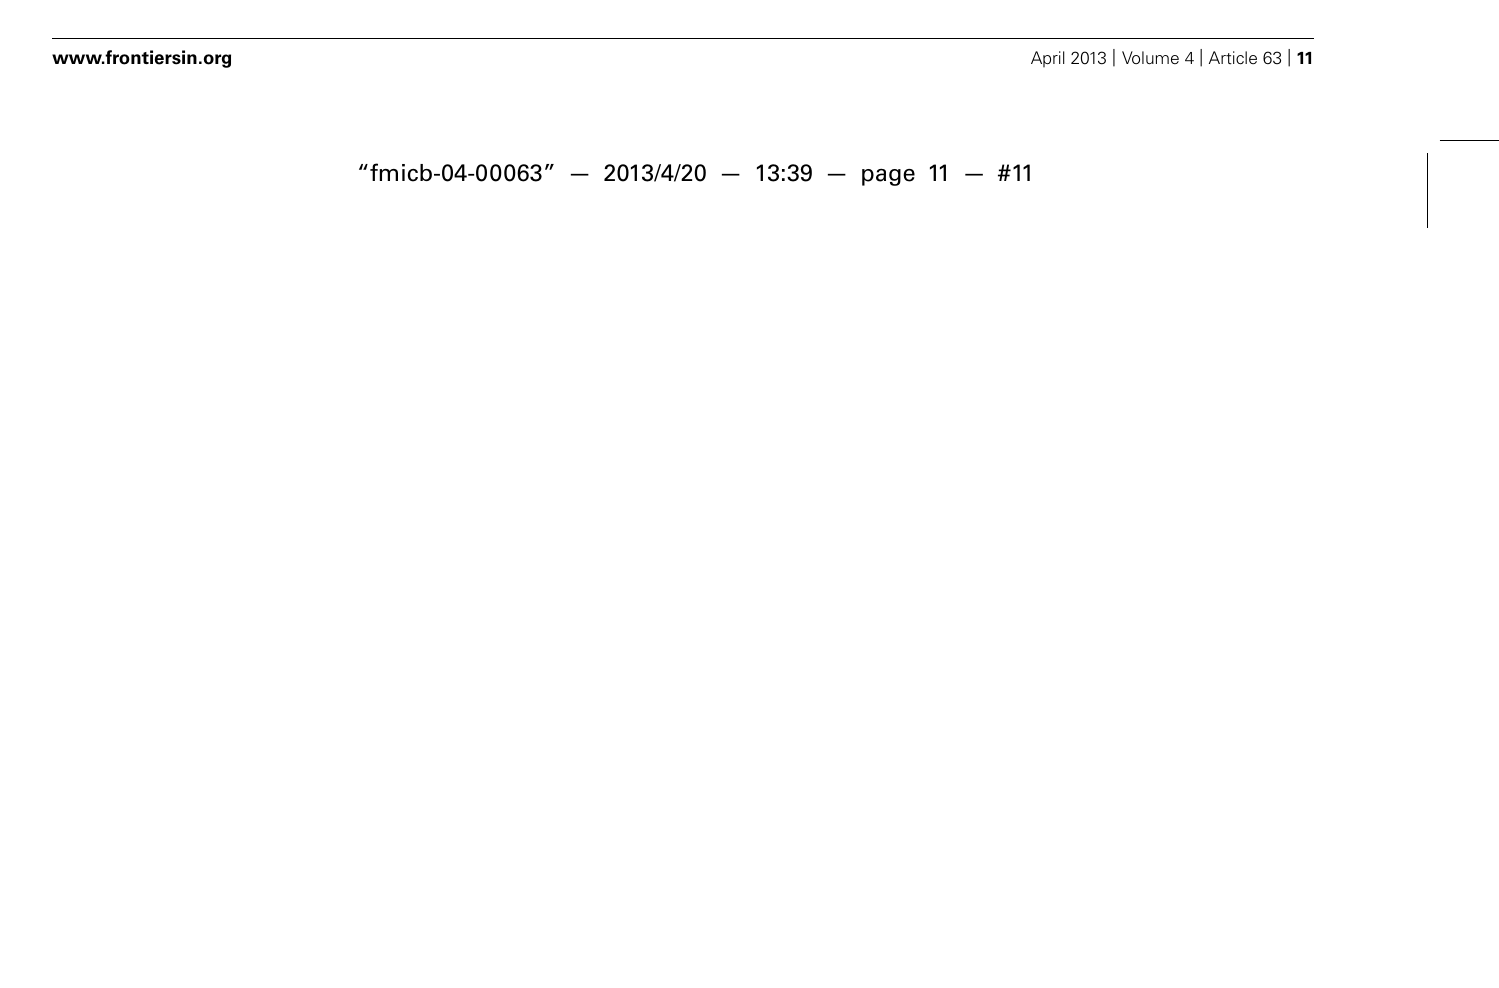
FIGURE 5 |A maximum-likelihood tree representing the phylogenetic relationships of the dominant Epsilonproteobacteria OTUs in the BF09-06 sulfur deposit to Epsilonproteobacteria reported from other sites. Bootstrap values of less than 50 are not shown and